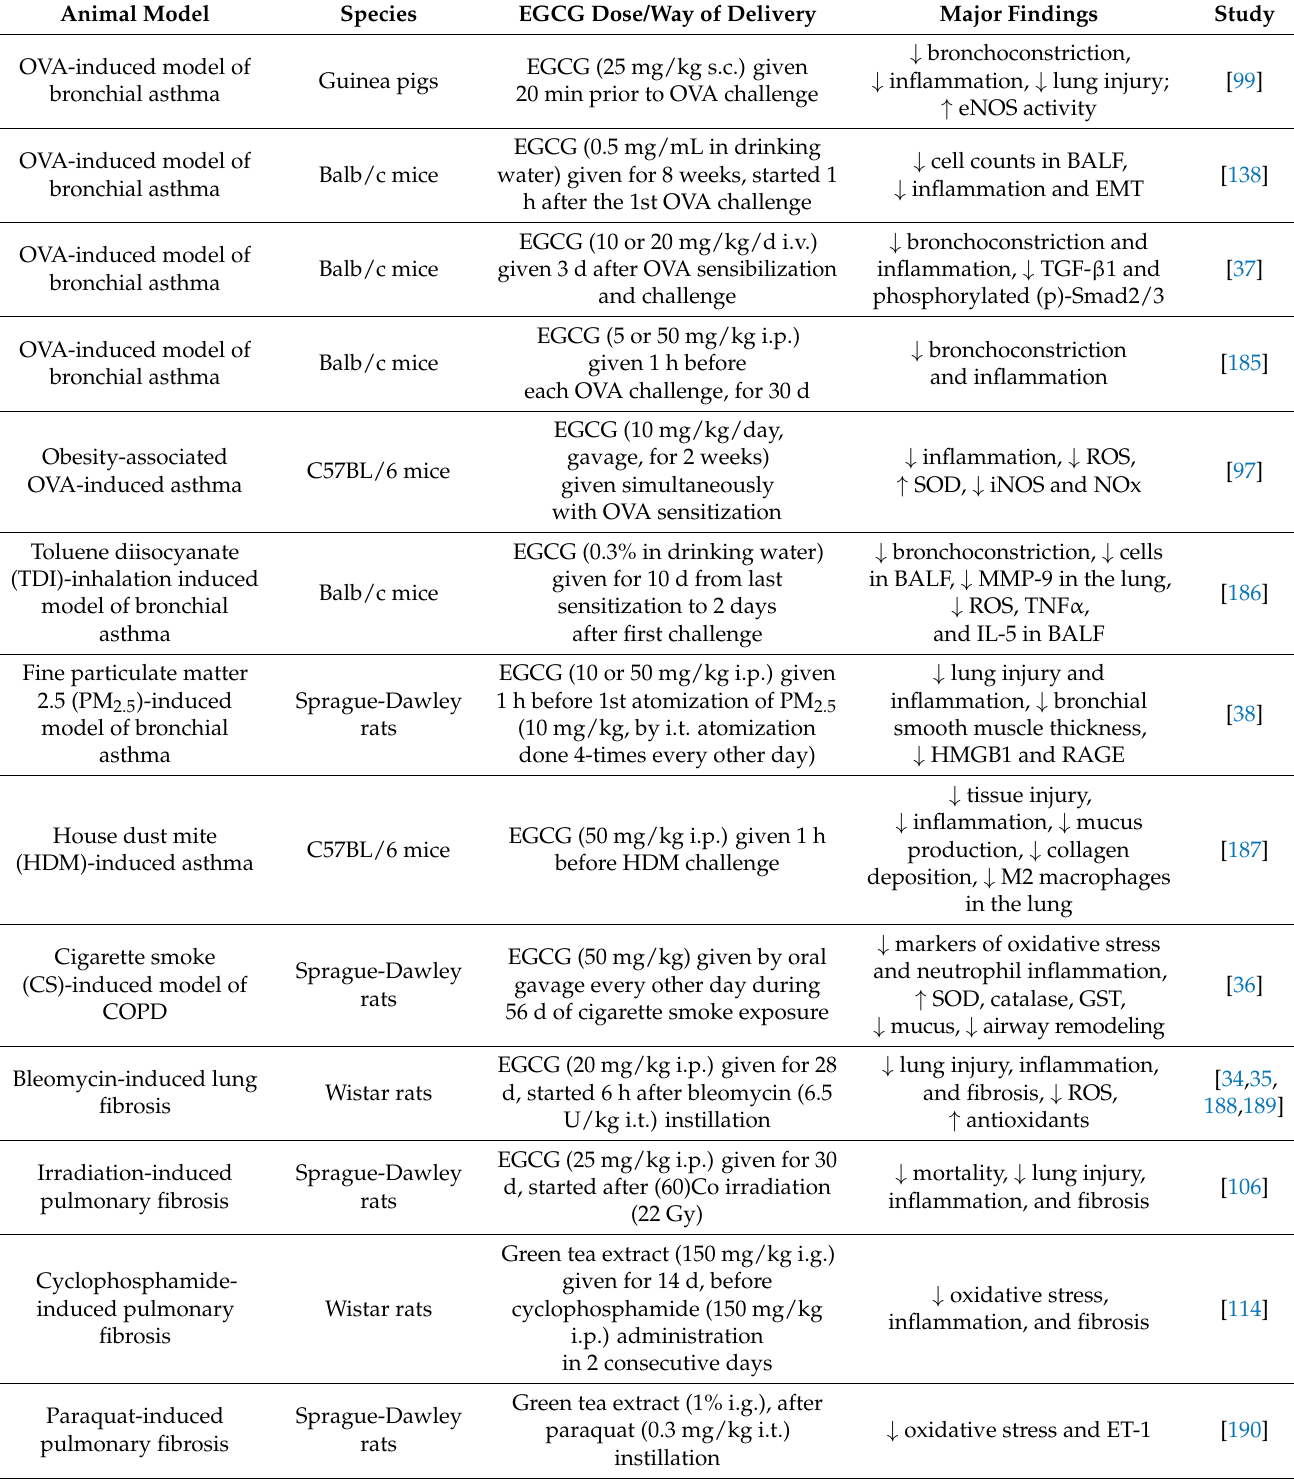
Table 3. EGCG in the treatment of bronchial asthma, COPD, lung fibrosis, silicosis, and lung cancer (animal models). For more details, see the